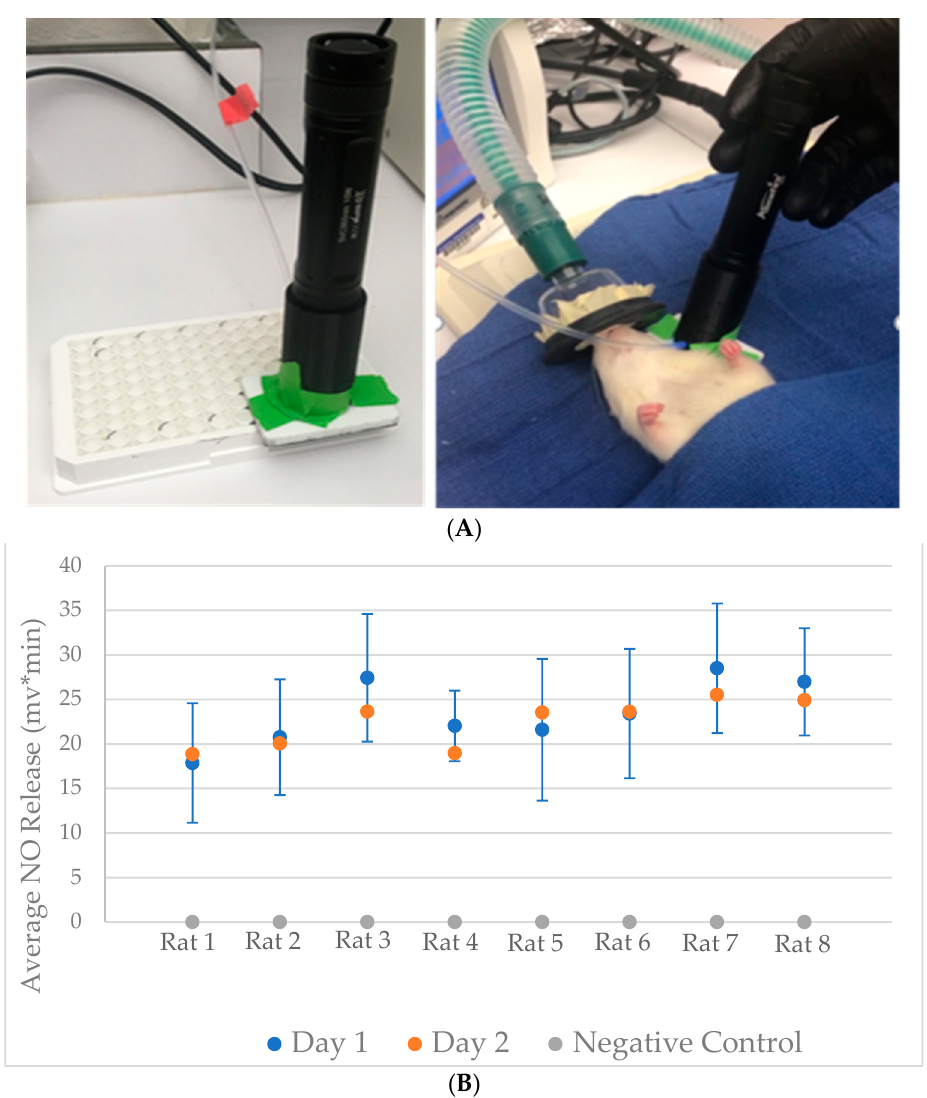
Figure 3. Photolytic NO determination in the rat. ( A ). The photolysis system applied in vitro (left) and to the rat’s ear (right). ( B ). UV probe on rat ears produced a reproducible signal on two-day replicates ( n = 3 each on each day). The signal from the NOA is shown in mV*sec. Blue is day 1, orange is day 2. Grey represents the baseline control (signal before the UV light is turned on; n = 3 per rat).